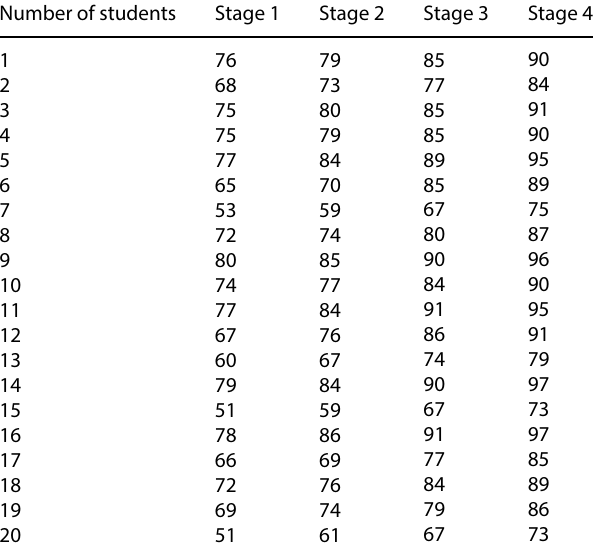
Table 9 The comprehensive scores at different learning